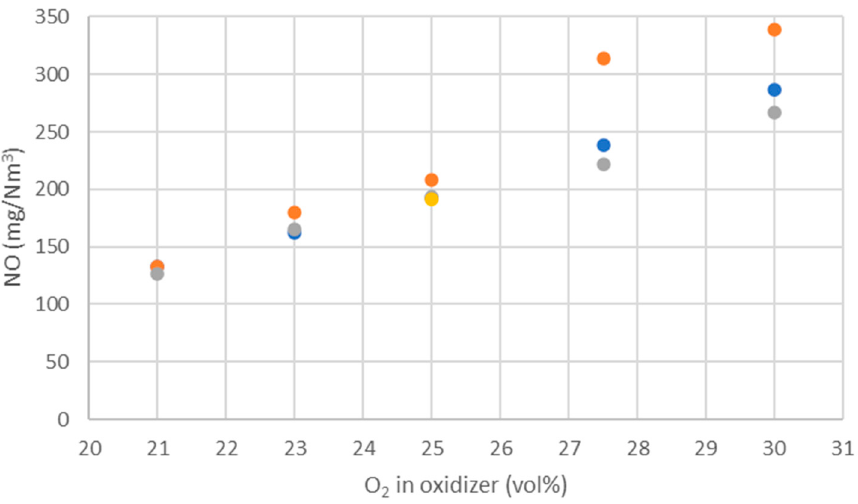
Figure 8. NO x emissions as a function of O 2 input concentration. O 2 /CO 2 (orange and yellow) and O 2 /N 2 (blue and grey) mixtures. Similar conditions (1000 ◦ C, 1.3 kg/h, 160 NL/min (except the O 2 /N 2 (blue and grey) mixtures. Similar conditions (1000 °C, 1.3 kg/h, 160 NL/min (except the high- highest point at 30%, 150 est point at 30%, 150 NL/min)).